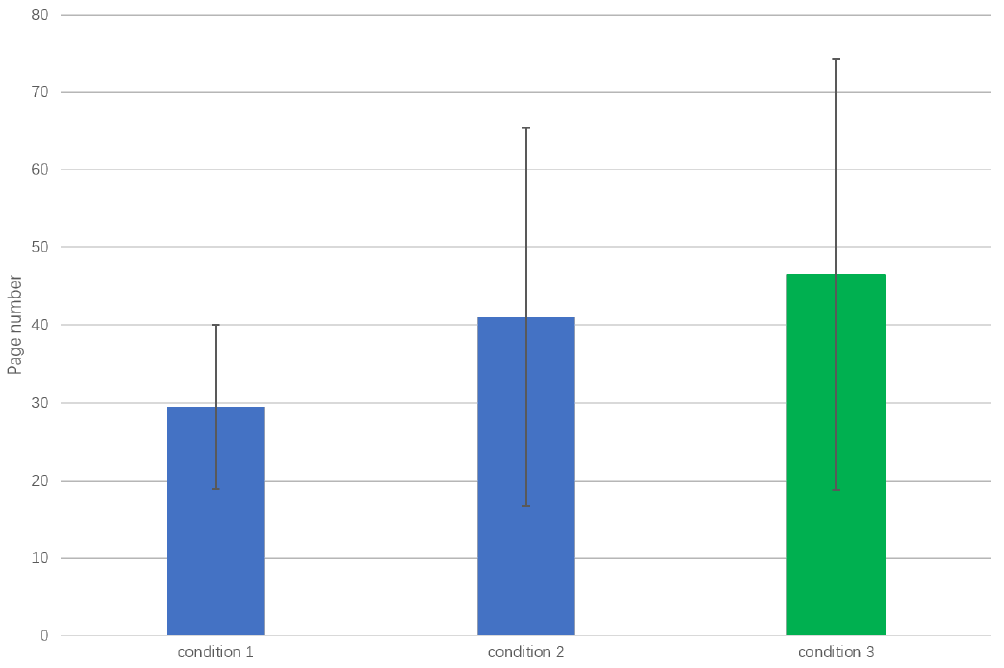
Figure 7. Average number of pages per session per person.